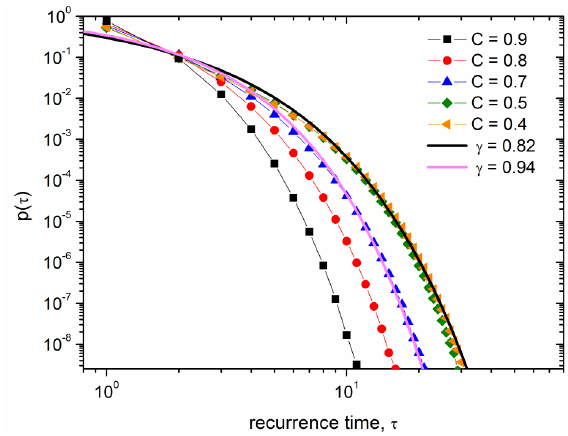
Fig. 4. Recurrence time distribution p(τ) for different values of the Figure 4. Recurrence time distribution p (  ) for different values of the conservation value C . In the 2 conservation value C . In the simulations, the values of the threshold simulations, the values of the threshold q and driving rate  are kept constant, ( q = 5 and  = 0.003). 3 q and driving rate ν are kept constant ( q = 5 and ν = 0.003). Also shown are two Weibull distributions with 1 /β = 1.15 and shape pa- Also shown are two Weibull distributions with 1/  = 1.15 and shape parameters  = 0.82 (black 4 rameters γ = 0.82 (black line) and γ = 0.94 (magenta line) and  = 0.94 (magenta line). 5